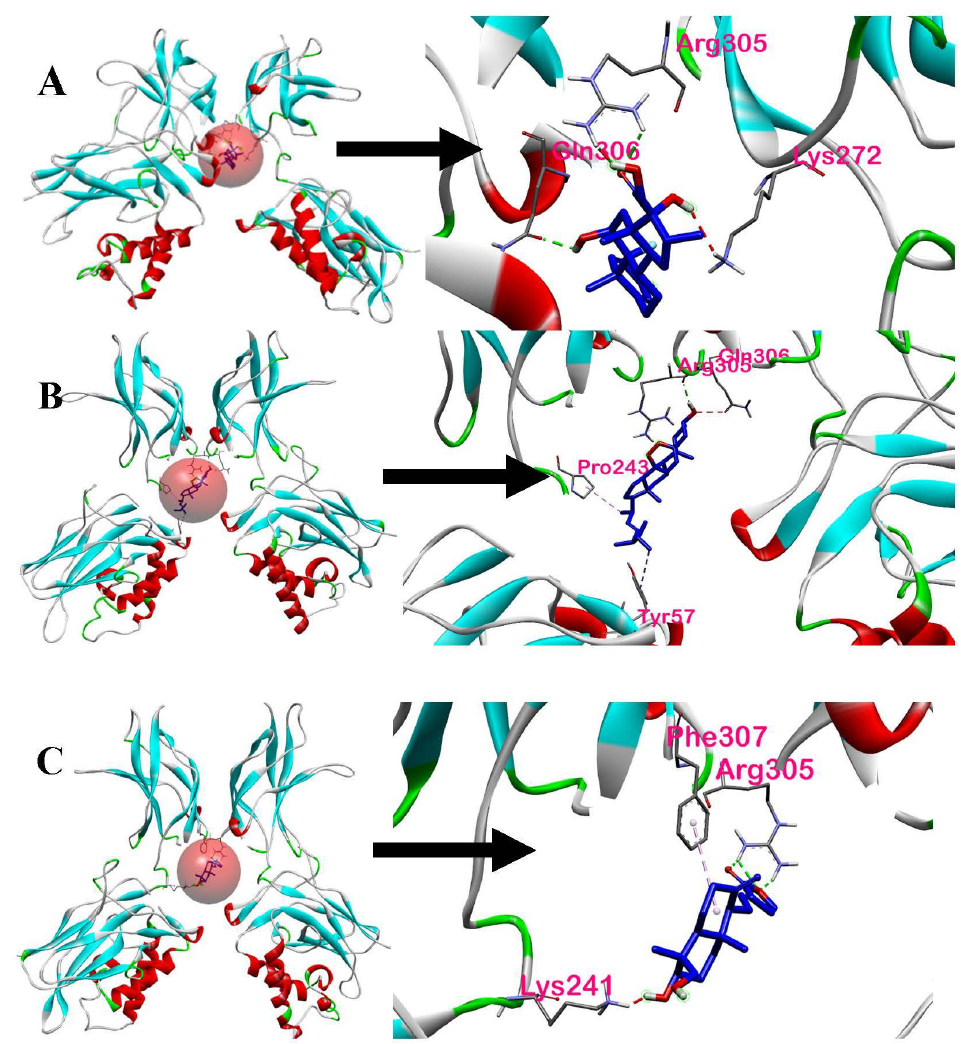
Figure 14. Receptor-ligand interactions: ( A ) dexamethasone with NF-κB p50, ( B ) ergosterol peroxide with NF-κB p50, and ( C ) 14-deoxy-14,15-dehydroandrographolide with NF-κB p50.